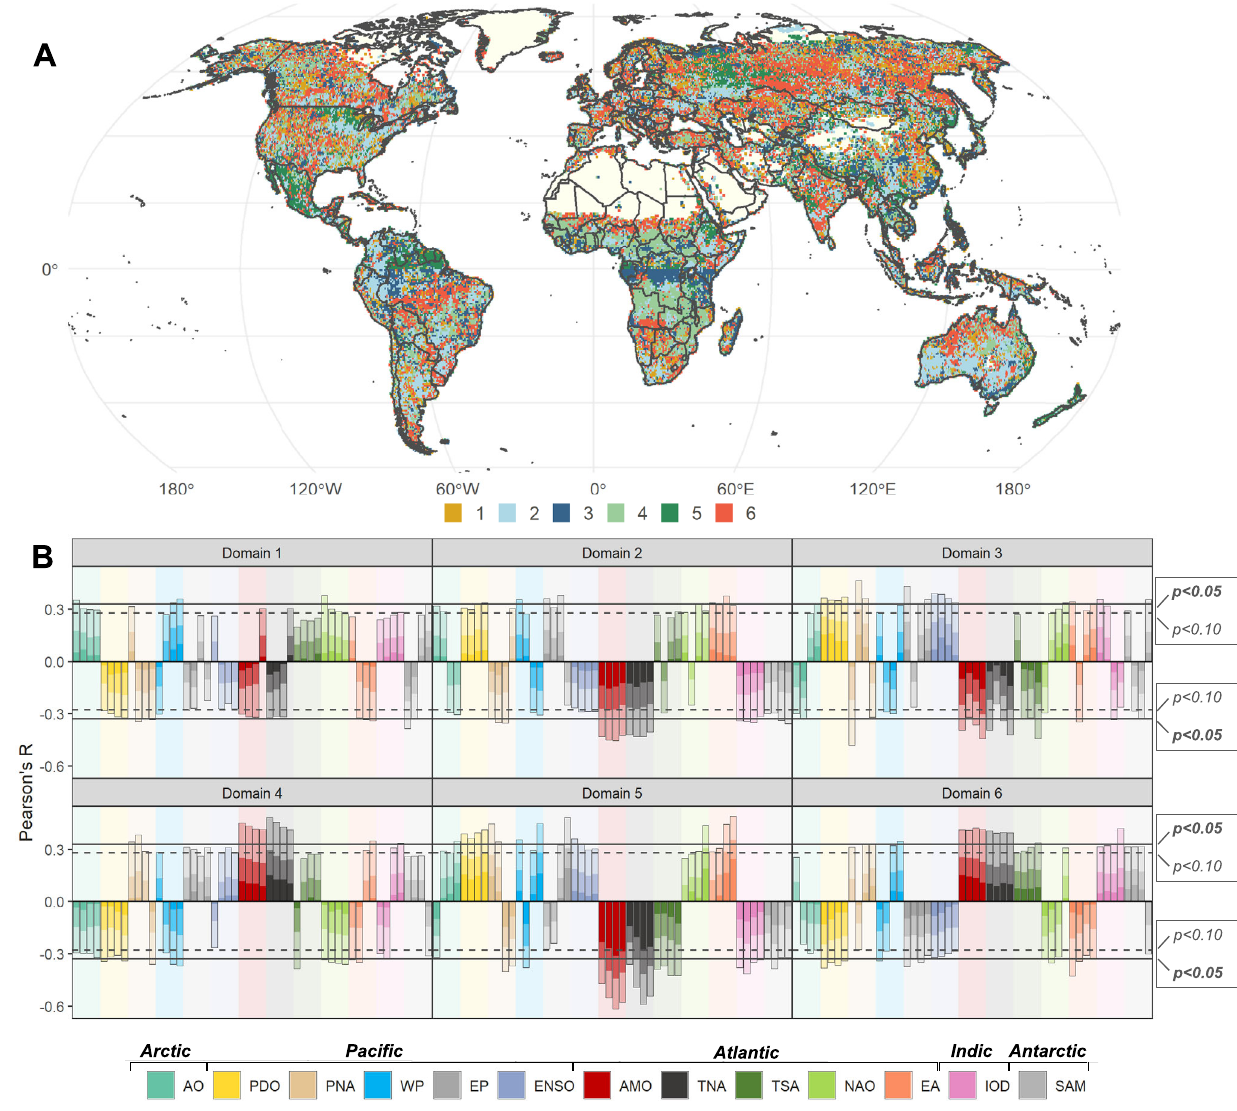
Fig. 3 | Climate teleconnection domains (CTD) characterizing CT- fi re associa- tionsworldwide. Thesedomainswerederivedbyapplyingahierarchicalclustering approachtothecorrelationcoef fi cientsobtainedforthedifferentcombinationsof CTs and lag windows at pixel level. A Spatial distribution of the six CTD. B Characterization of the CTD based on the relationship between each CT and burnedarea ata giventime lag.Colored barsindicate the corresponding CT;color brightness relates (from darker to lighter) to the median, 75th and 95th percentile